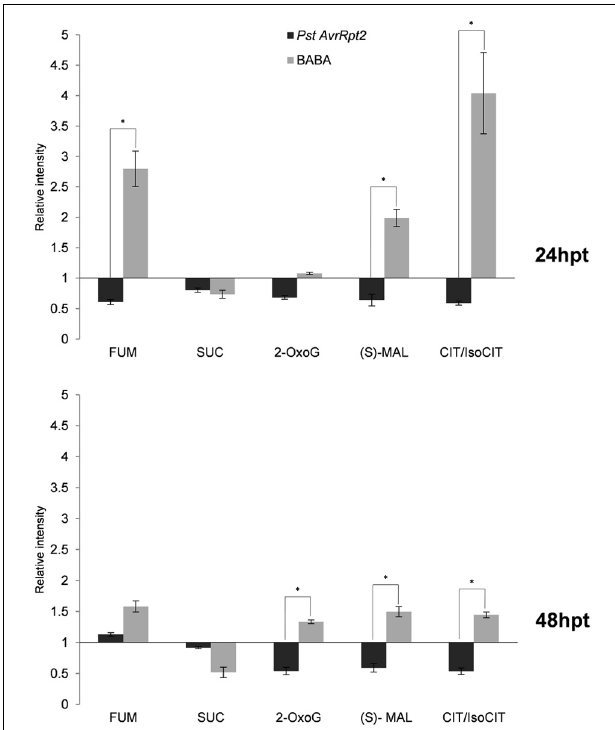
FIGURE 3 | Profile of compounds related to the tricarboxylic acid cycle. Four five-week-old Col-0 plants were processed for relative quantification after 24 and 48hpt. The concentration of metabolites was obtained by normalizing the chromatographic area of each compound to the dry weight of the sample. The bars show the relative accumulation (relative intensity) of each compound in respect to its control, BABA vs. water, PstAvrRpt2 vs. mock. Asterisks represent statistically significant differences (Wilcoxon Mann–Whitney test, p < 0 . 05, n = 6). Data represent the average of three independent experiments.